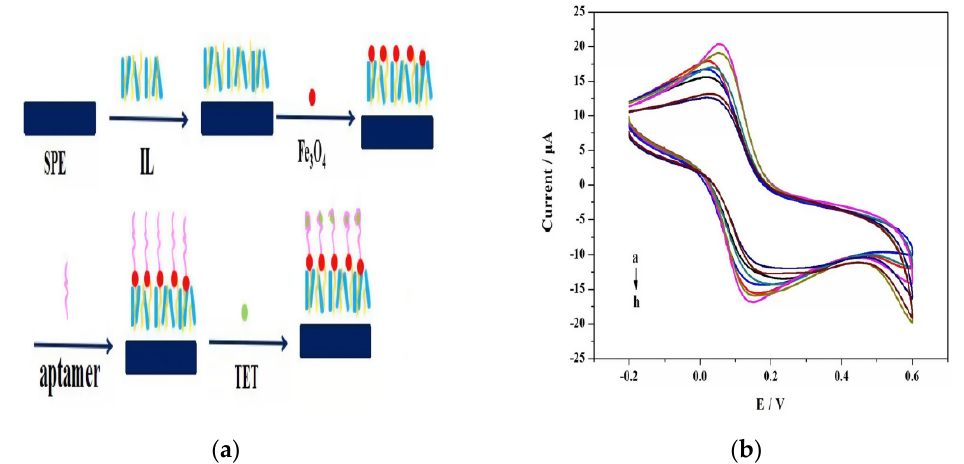
Figure 6. TET/Apt/Fe 3 O 4 /ionic liquid (IL)/screen-printed electrode (SPE) Aptasensor fabrication process ( a ), cyclic voltammograms of the aptasensor toward different concentrations of tetracycline (1.0 to 108 nM) ( b ). Reproduced from [89]. ESG